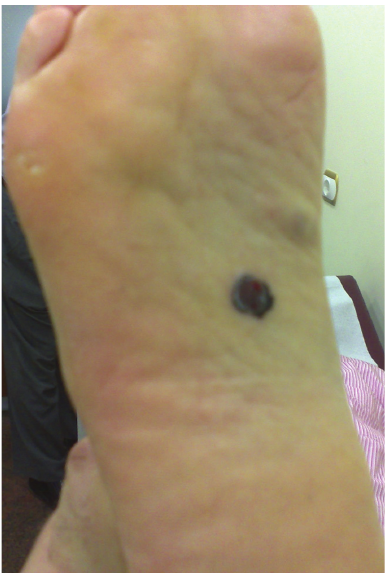
Figure 1: The lesion over the sole of patient’s right foot, measuring 15–20 mm in diameter.